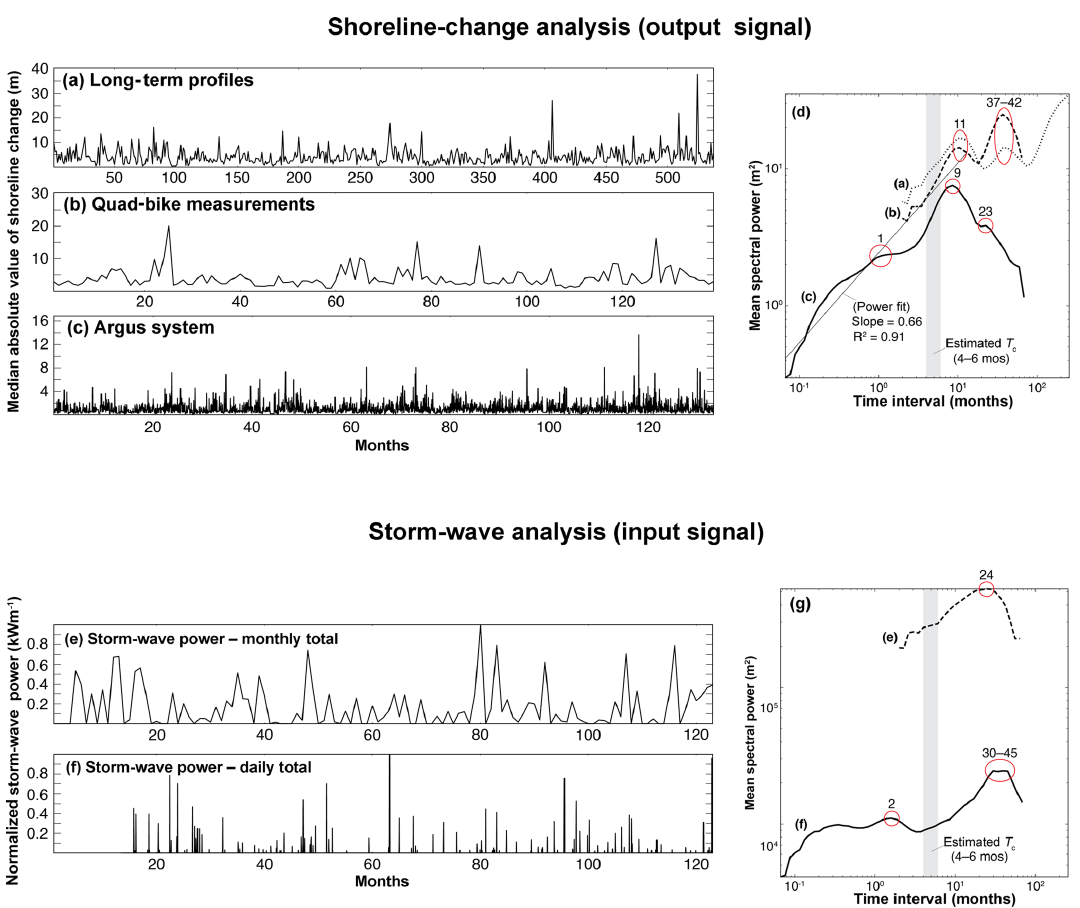
Figure 2. Shoreline-change analysis (upper panels): alongshore median of the absolute value of monthly shoreline change from (a) long-term Profiles 1, 2, 4, 6, and 8, (b) monthly shoreline position from the RTK-GPS quad-bike surveys, and (c) a 850m reach of the Argus coverage ( y = 1950–2800m). (d) Wavelet-derived power spectra for the three shoreline-change signals, respectively, showing a transition from non- stationary to stationary at timescales ∼ 10 1 months. A power function fitted to the three spectra, combined, for scales up to ∼ 12 months, returns a scaling exponent = 0 . 66. Storm-wave analysis (lower panels): (e) monthly and (f) daily total storm wave-energy flux between 2005 and 2017 (normalized to their respective maxima), used here to represent forcing input. (g) Power spectra for the storm-wave energy flux in panels (e) and (f) . Labelled circles emphasize major peaks in spectral density at various timescales. Grey bar in panels (d) and (g) indicates an estimated characteristic timescale T c = 4–6 months, based on normalized beach width relative to mean normalized wave-energy